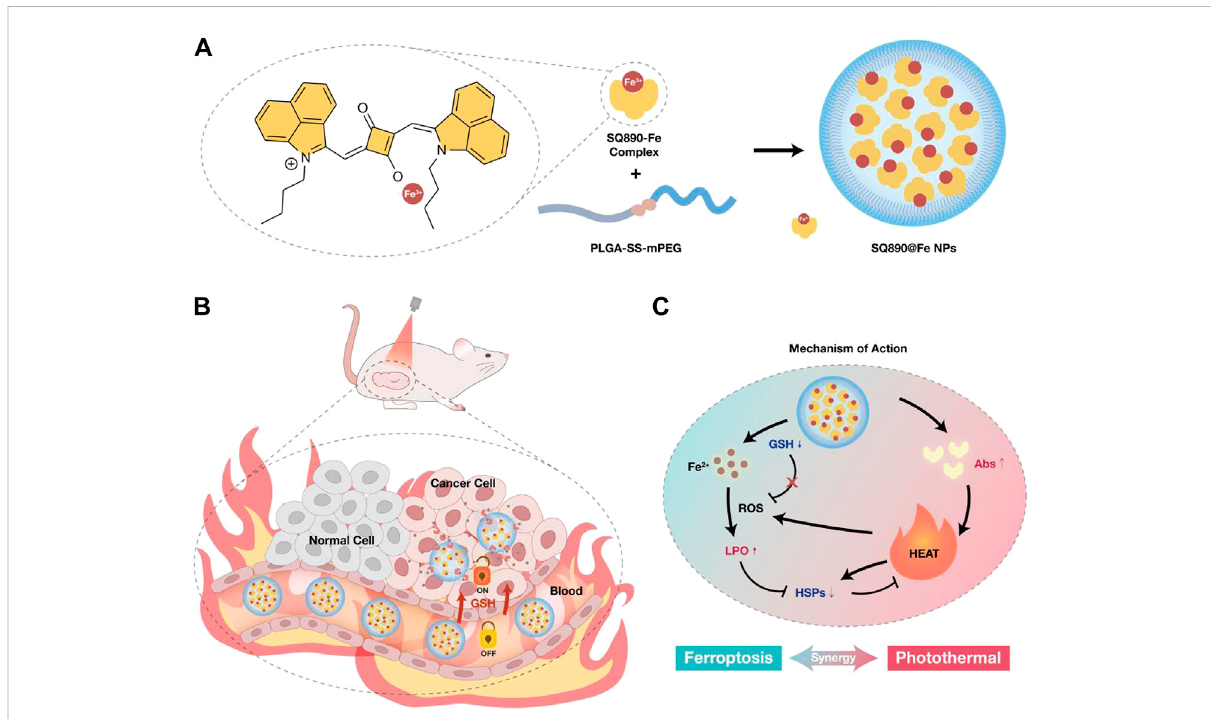
FIGURE 1 (A) Schematic of the preparation of SQ890-Fe 3+ complexes encapsulated with GSH-sensitive PLGA-SS-mPEG to attain SQ890@Fe